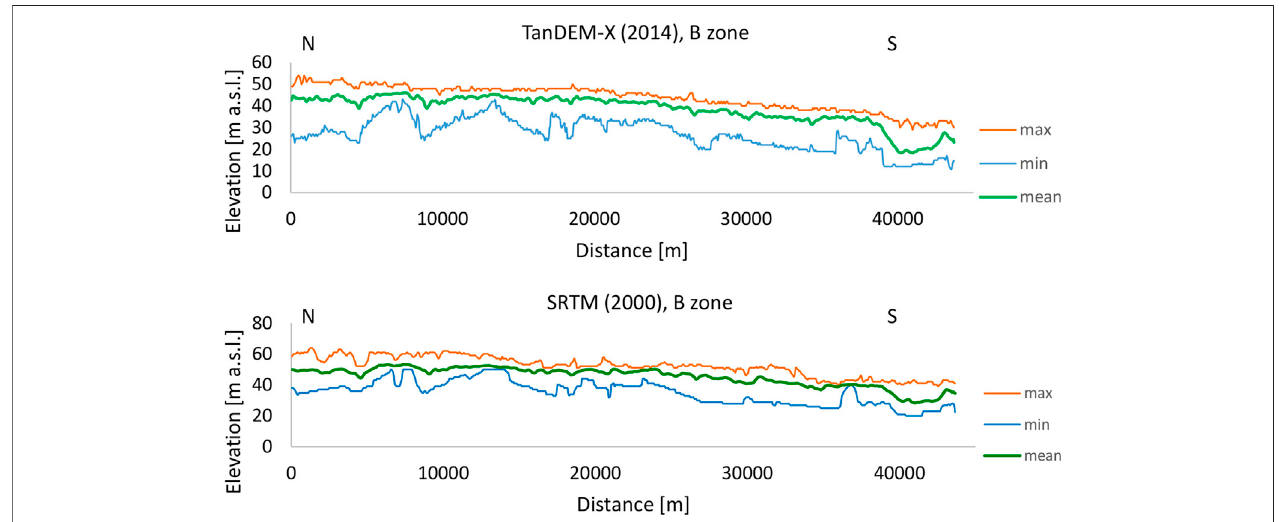
FIGURE7| North-Southswathpro fi lesacrosshotspotzoneB.Elevationmin,max,andmeanvaluesarederivedfromTanDEM-XandSRTMDEMdata.Themean elevation values show up to 2 m net mass loss over 14 years.